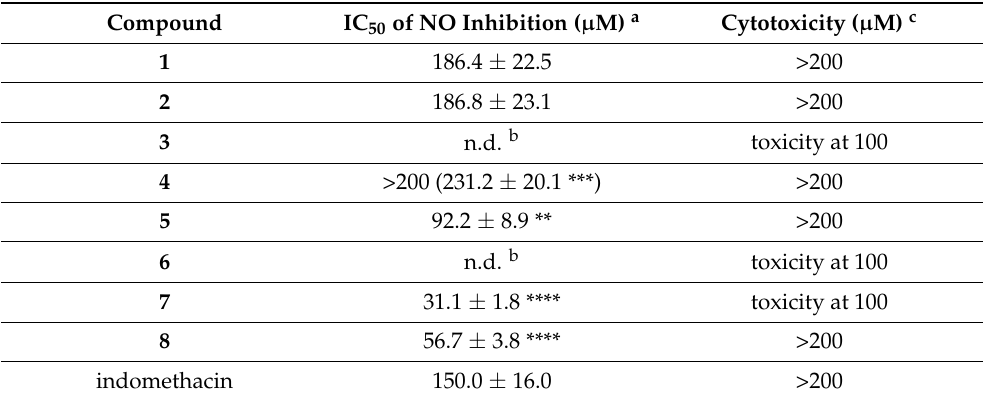
Table 5. Inhibition concentration of isolated compounds on nitric oxide (NO) production and cytotoxicity in LPS-induced RAW 264.7